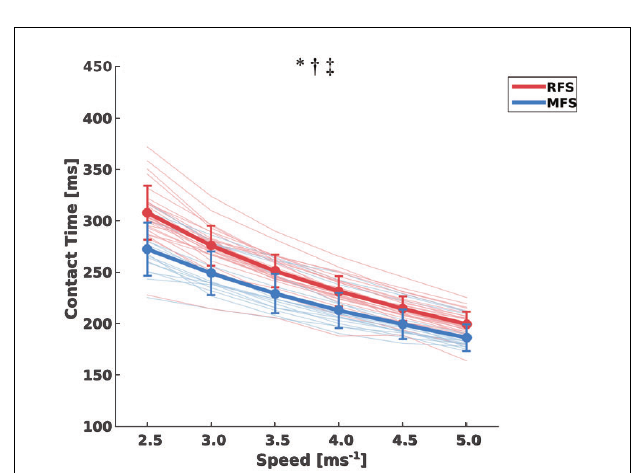
FIGURE 2 | Mean ± standard deviation of contact times [ms] throughout the examined speeds and the individual values for both rearfoot strikers (RFS) and mid-forefoot strikers (MFS). *: statistically significant speed effect ( p < 0.05); † : statistically significant group effect ( p < 0.05); ‡ : statistically significant group x speed interaction ( p < 0.05) indicating a greater decrease of contact time in RFS